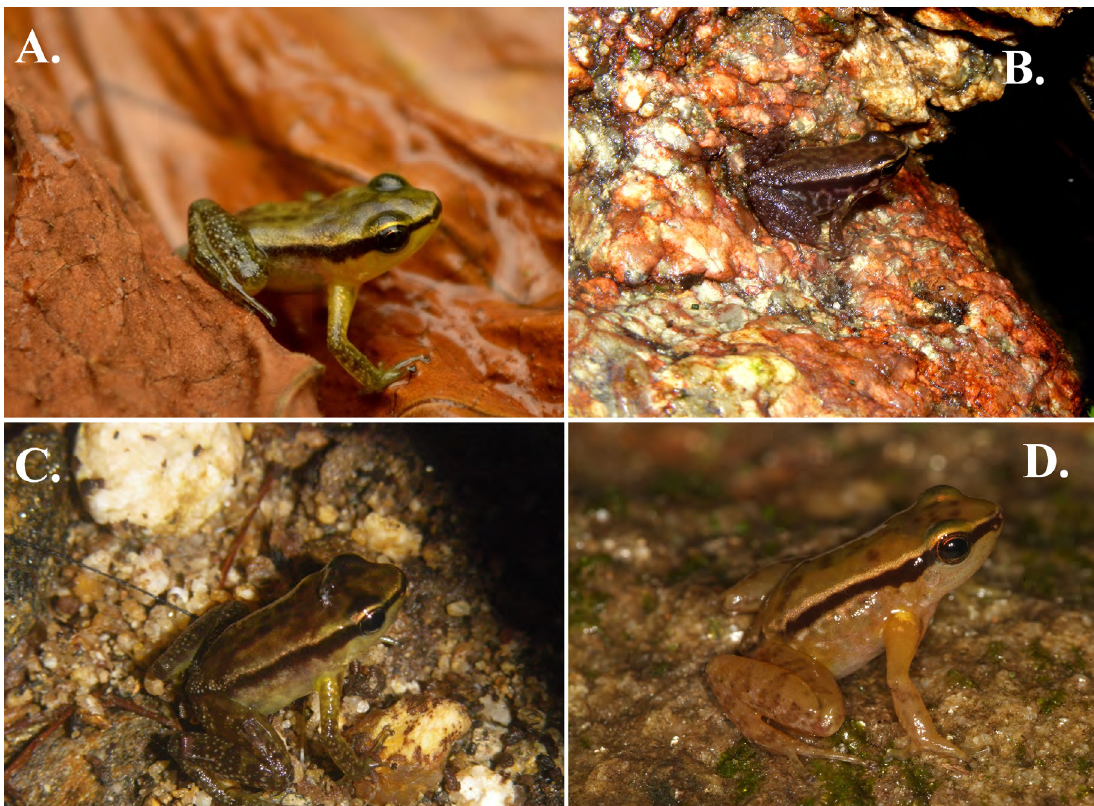
Colostethus ruthveni Figure 1. Images of the species in its habitat. A. Río Buritaca (Photograph by Liliana Saboyá). B. Nabusimake (Photograph by Hernan Granda) C. Río Piedras. (Photograph by Liliana Saboyá) D. Río Frío (Photograph by Juan Manuel